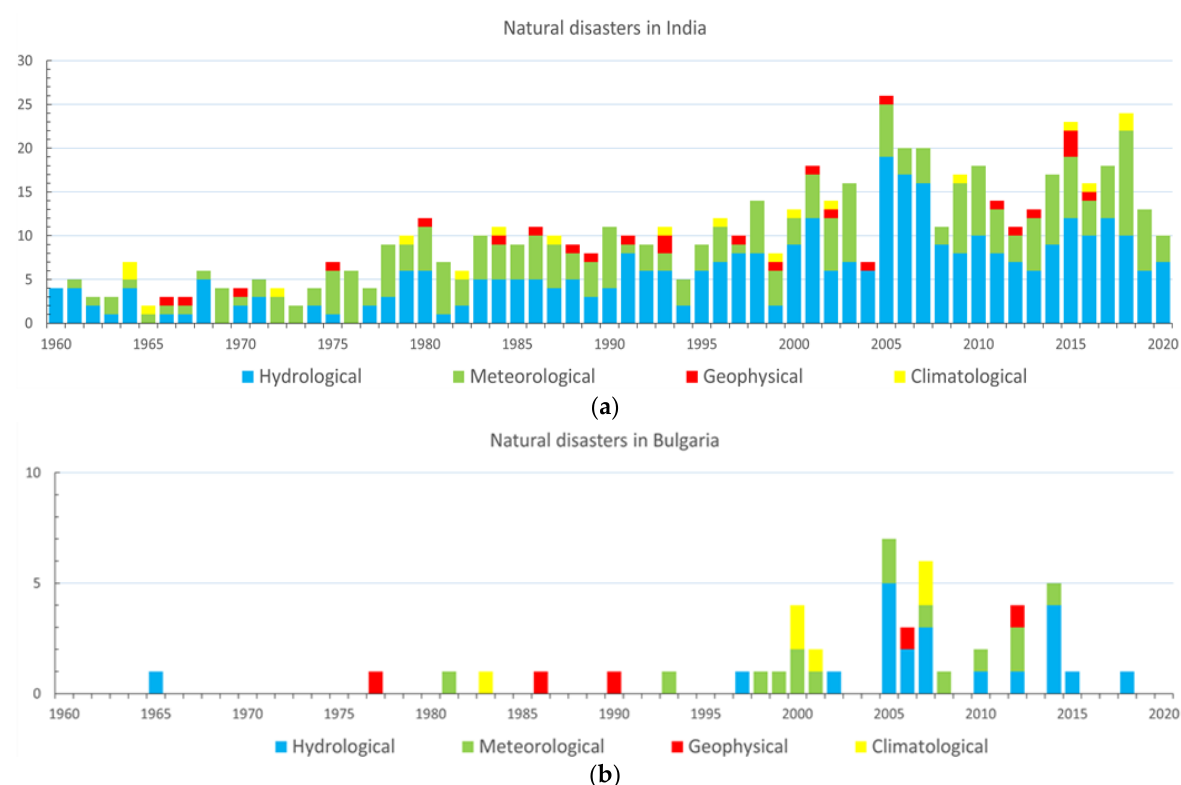
Figure 3. Disasters in India ( a ) and Bulgaria ( b ) for the period 1960–2020 (Data source: [60], accessed on 29 January 2021).